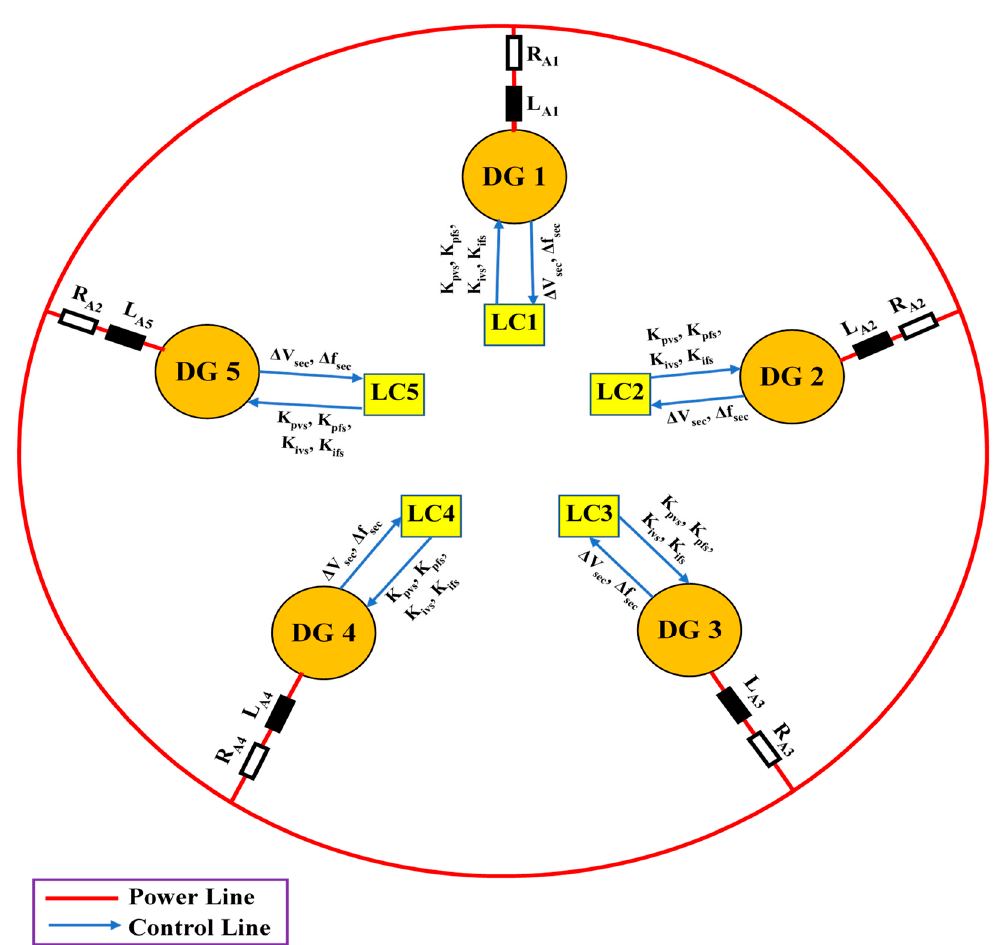
Figure 6. Intelligent decentralized secondary control structure.